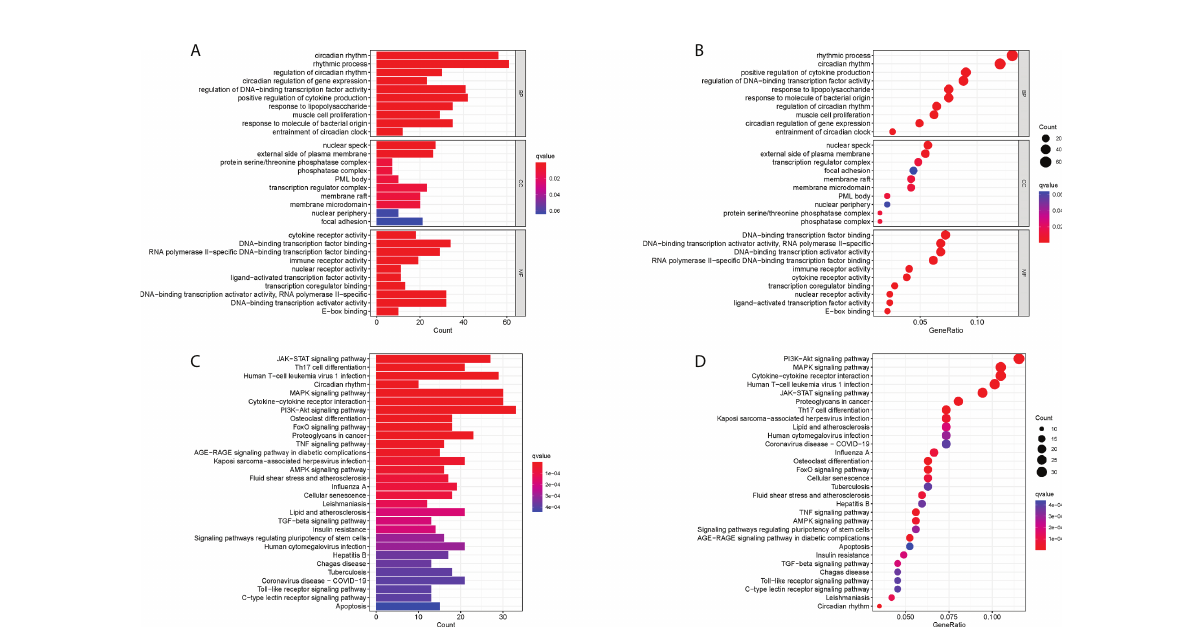
FIGURE 3 Functional correlation analysis of DECRGs between RA and control groups. (A, B) The results of GO analysis were presented by bar plot and bubble graph. (C, D) The results of KEGG pathway analysis were shown by bar plot and bubble graph. BP, biological process; CC, cellular component, MF, Molecular